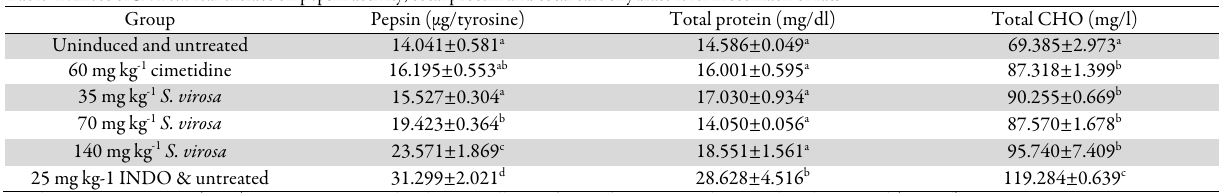
Table 4. Effect of S. virosa leaf extract on pepsin activity, total protein and total carbohydrate level in stomach of rats Group